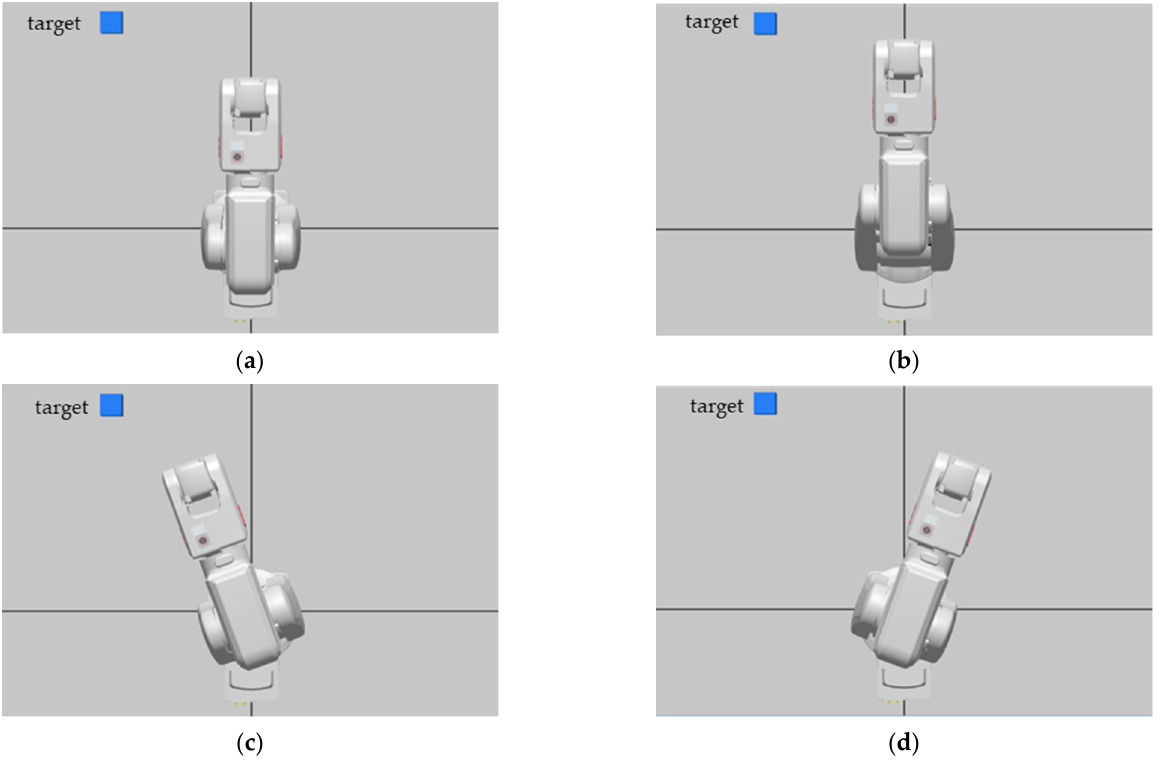
Figure 7. ( a ) Home position of the robot arm, ( b ) forward movement, ( c ) left movement, ( d ) right